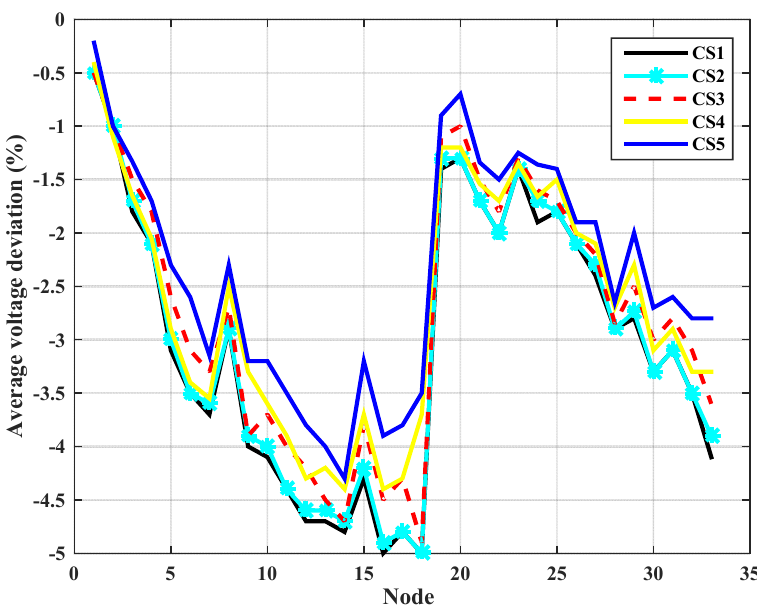
Figure 9. Average nodal voltage deviations for different CSs over a day horizon. Energies 2018 , 11 , x FOR PEER REVIEW